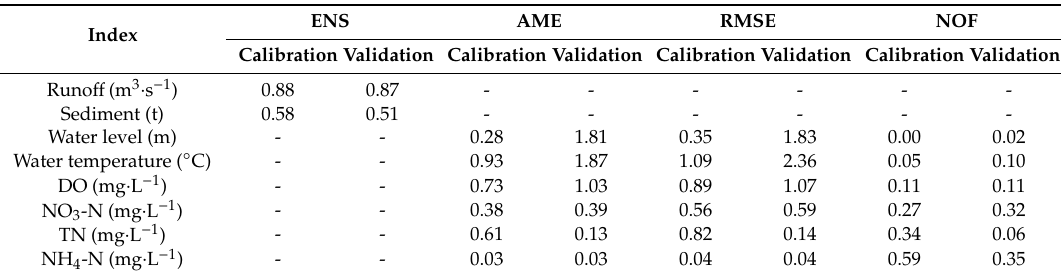
Table 1. Calibration and validation results of the hydrological and water quality indexes for the Soil and Water Assessment Tool (SWAT) model and the two-dimensional hydrodynamic and water quality model